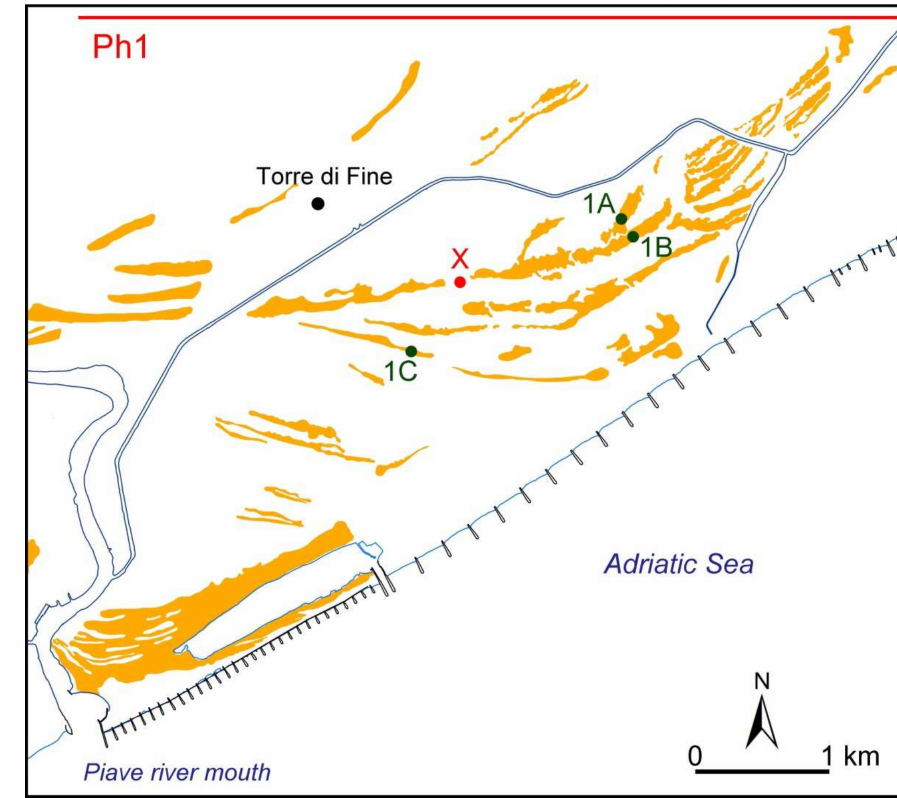
Figure 2. Evidence of the paleo-delta recognized SE of Torre di Fine (rectangle A in Figure 1) (first progradation phase, Ph1). The green dots indicate core locations, whereas the red dot shows the position of the radiocarbon dating (5460 ± 60 yr